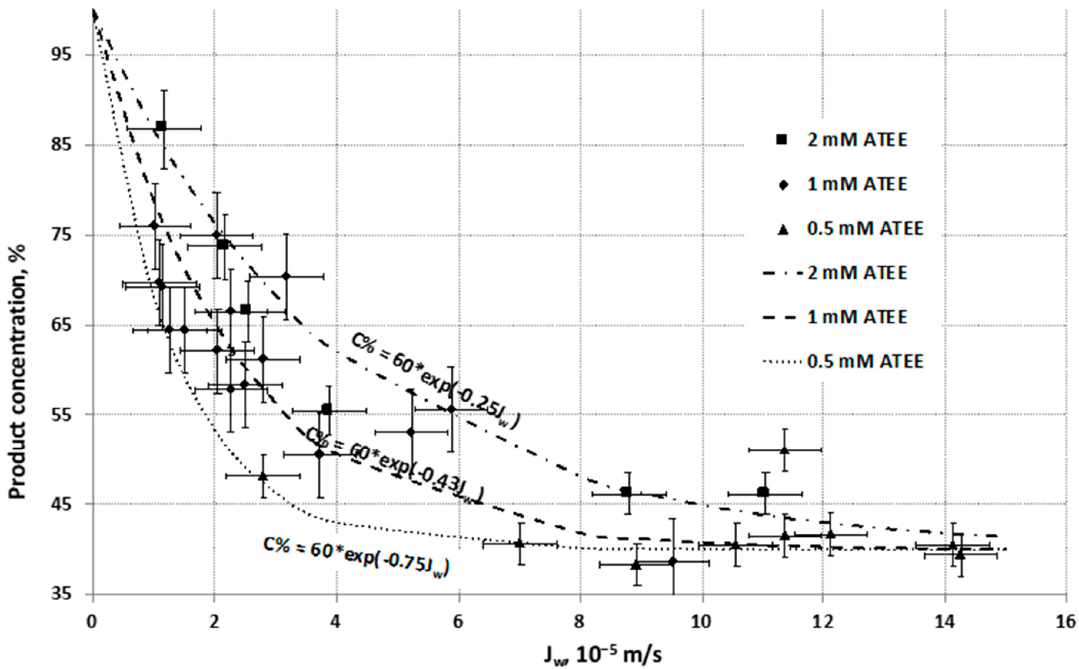
Figure 6. Change of the product concentration of enzyme catalytic membrane bioreactor (%) in the function of convective flow rate ( J w ), applying di ff erent inlet substrate concentrations (0.5, 1 and 2 mM ATEE). All curves could well describe exponential functions with negative exponent (see continuous, tagged and dotted lines as calculated values) (Product concentration in % [ C p ] can be calculated as: C p = C so - C s, where C so is the substrate concentration at the starting time, i.e., at t = 0), while C s is that at t = t . (Standard errors values are plotted. They have varied between ± 4 and 6% of measured mean